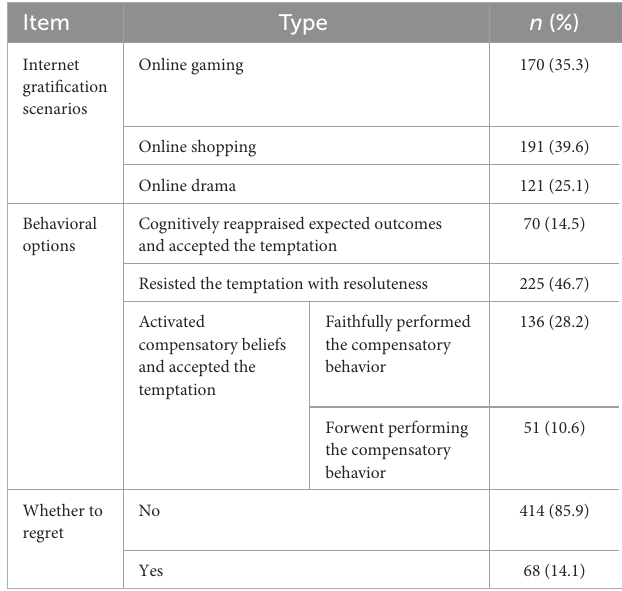
TABLE 1B The descriptive statistics of GBA-IGB for organizational employees ( N = 482).